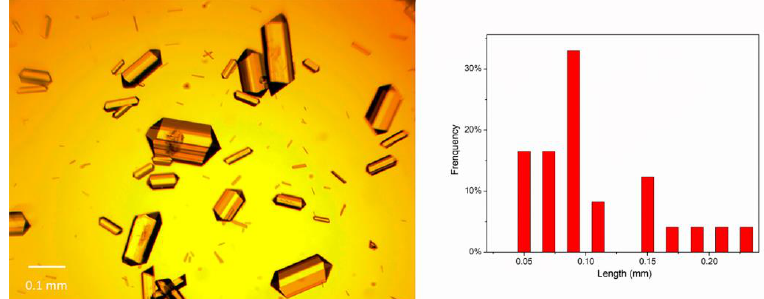
Figure 6. ( Left ) Representative microscopy images (with polarizer) of crystals in slugs from Conditions 4 in Table 1. The slug aspect ratio is also 0.8. ( Right ) Crystal size distribution (CSD) of the microscope image on the left.